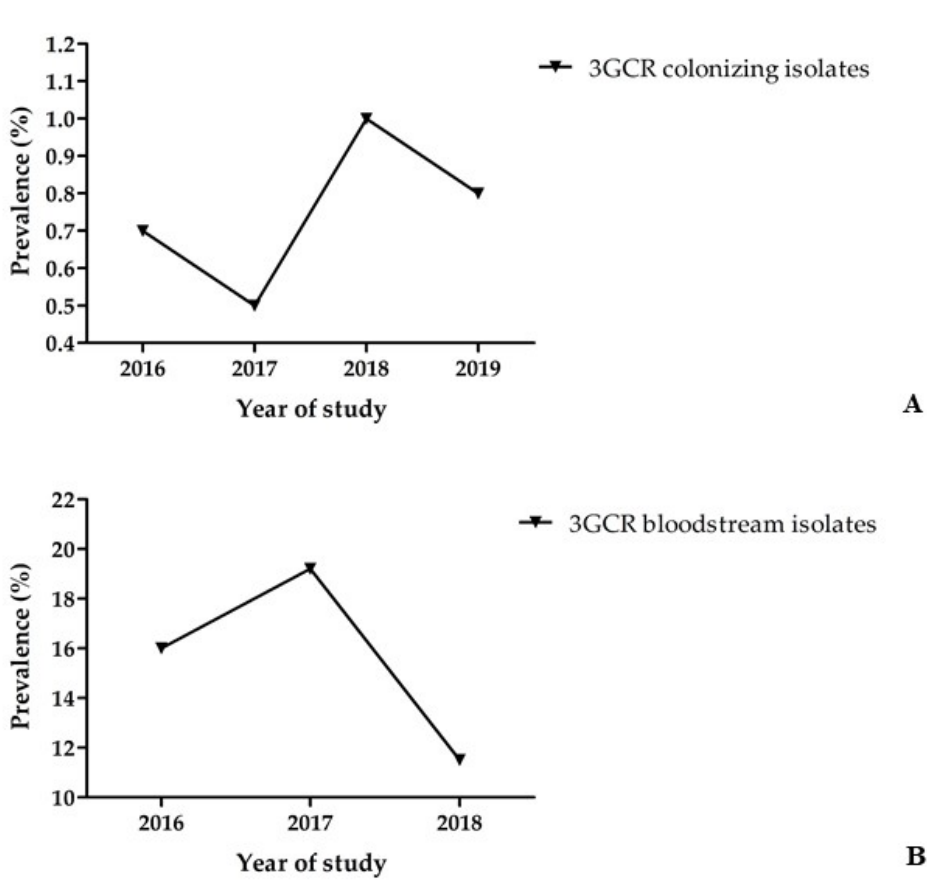
Figure 1. ( A ) Prevalence of 3GCR K. pneumoniae complex carriage of patients on hospital admission. ( B ) Prevalence of 3GCR among 880 K. pneumoniae complex bloodstream isolates.